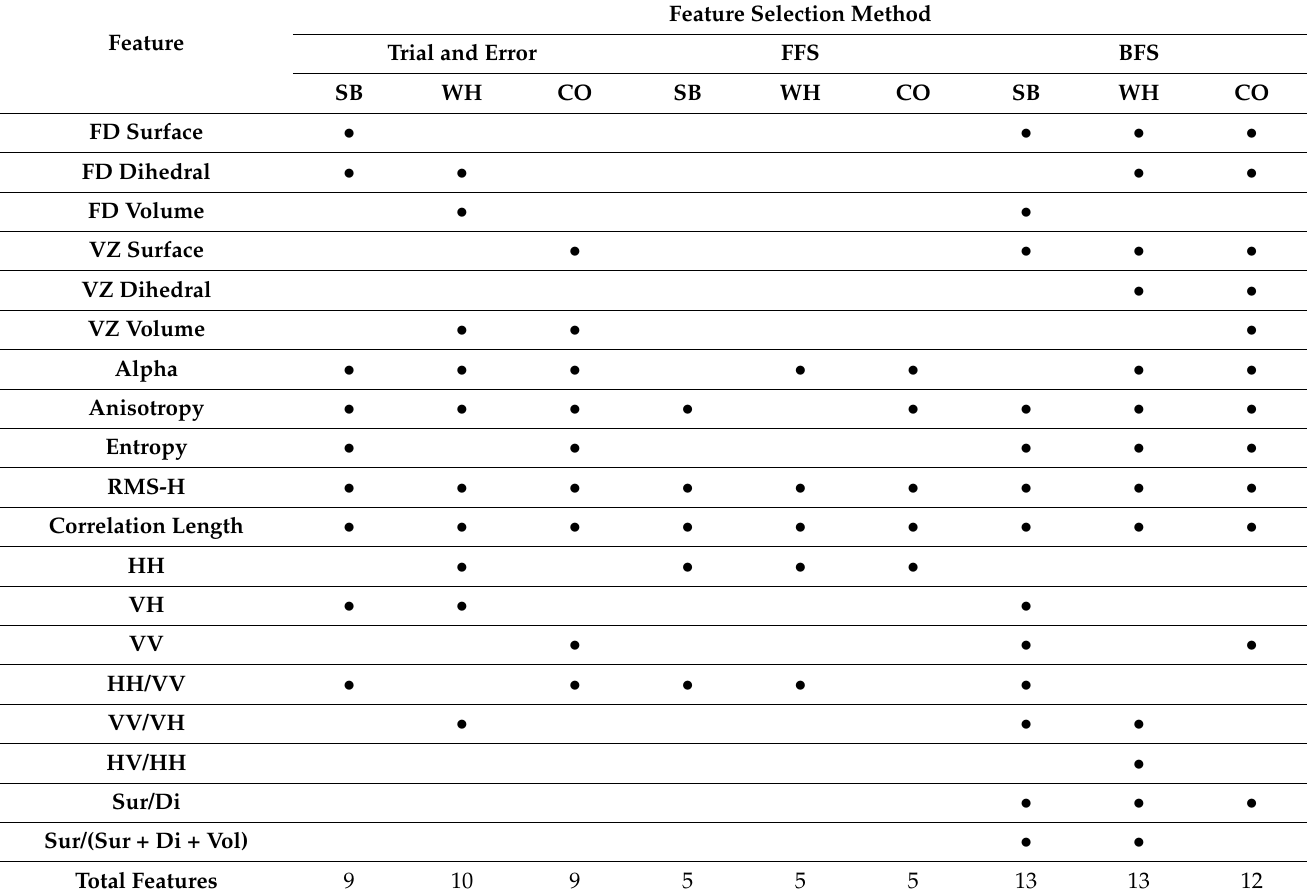
Feature Selection Method